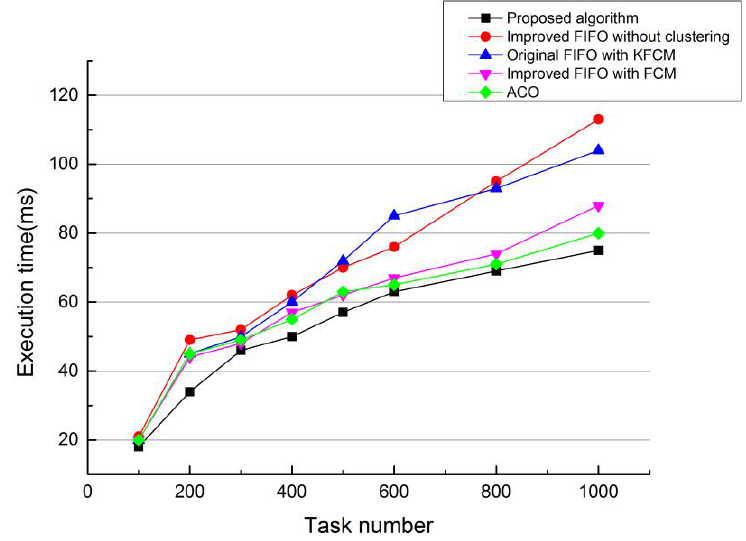
Figure 5. Execution time of the four algorithms.